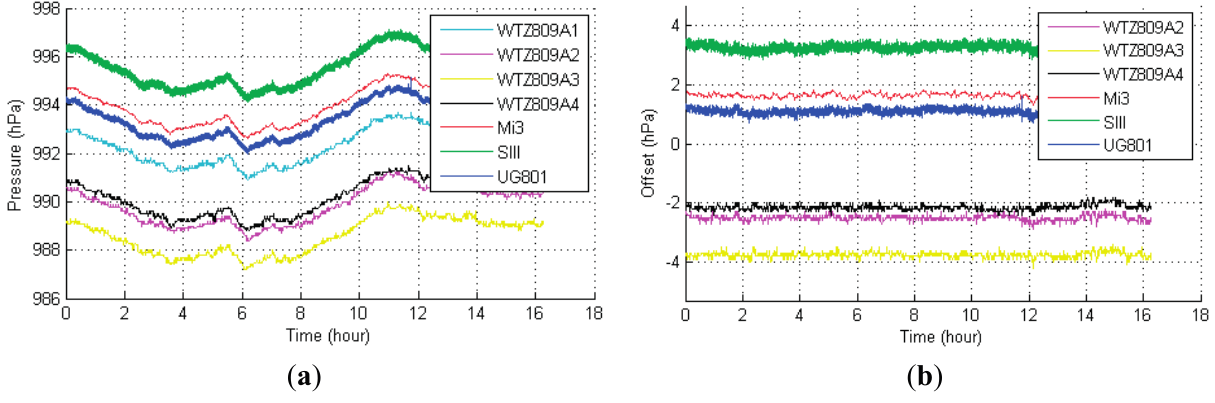
Figure 3. ( a ) Absolute pressure reading from seven sensors. WTZ809A1–WTZ809A4 are barometers with MS5540C, Mi3 and UG901 are smart phones with BMP180, and SIII is a smart phone with LPS331AP; ( b ) WTZ809A1 used as the standard and offsets of the